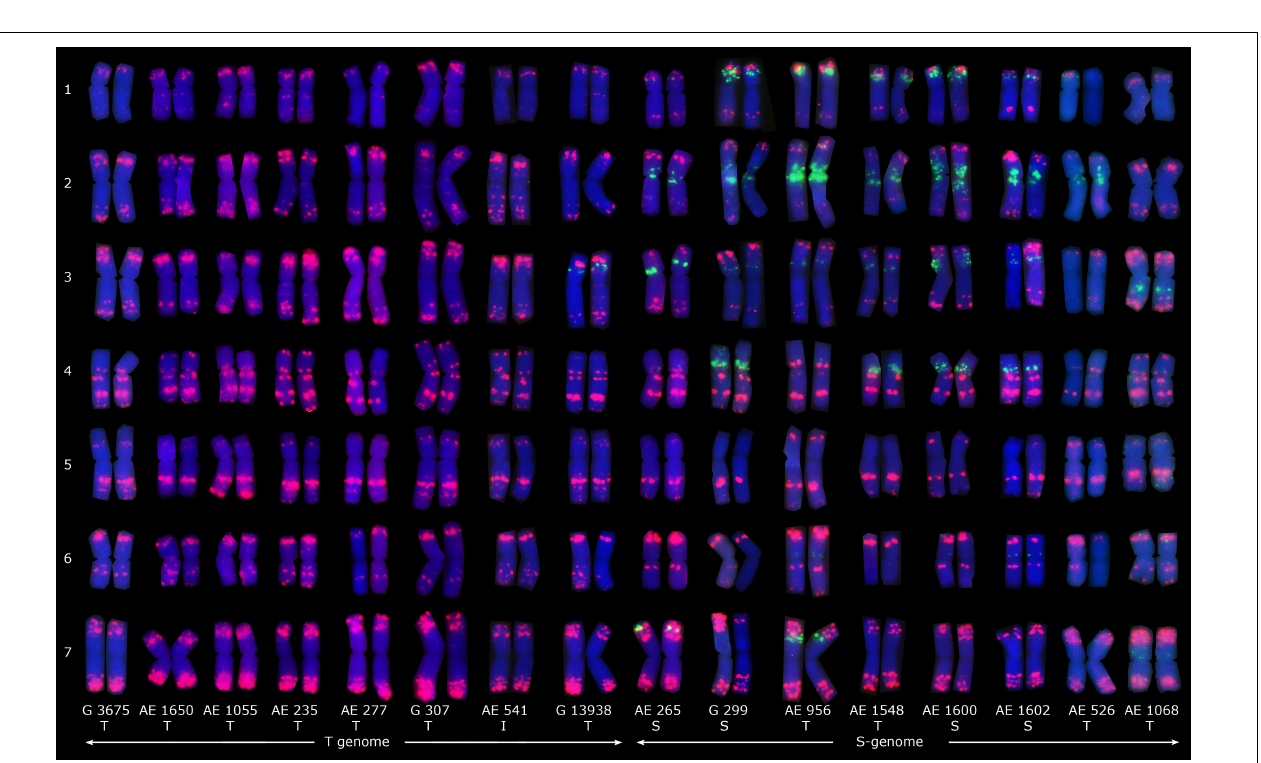
Frontiers in Plant Science |